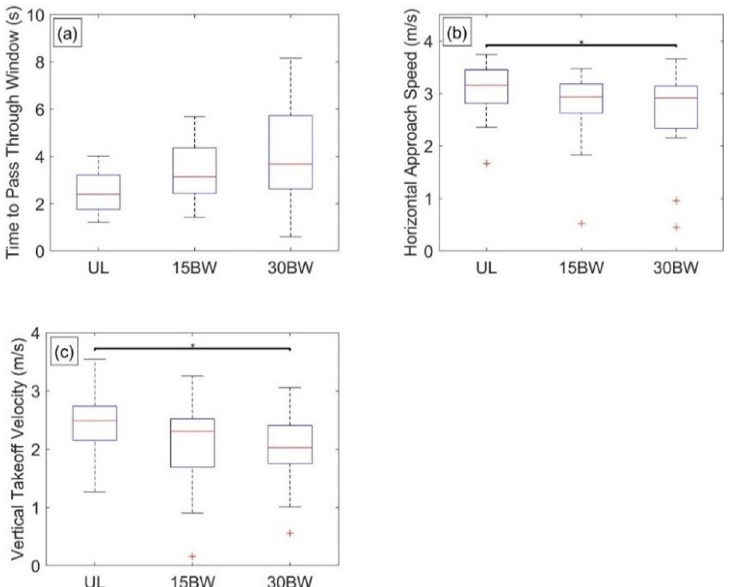
Fig 8. Window statistical results. Boxplots depicting the results from the Tukey post hoc analysis of window obstacle metrics for a) time to pass through the window opening, b) horizontal approach velocity, and c) vertical takeoff velocity. The bars denote significant differences between loading conditions at a significance level α = 0.05 � , 0.01 �� , 0.001 ���